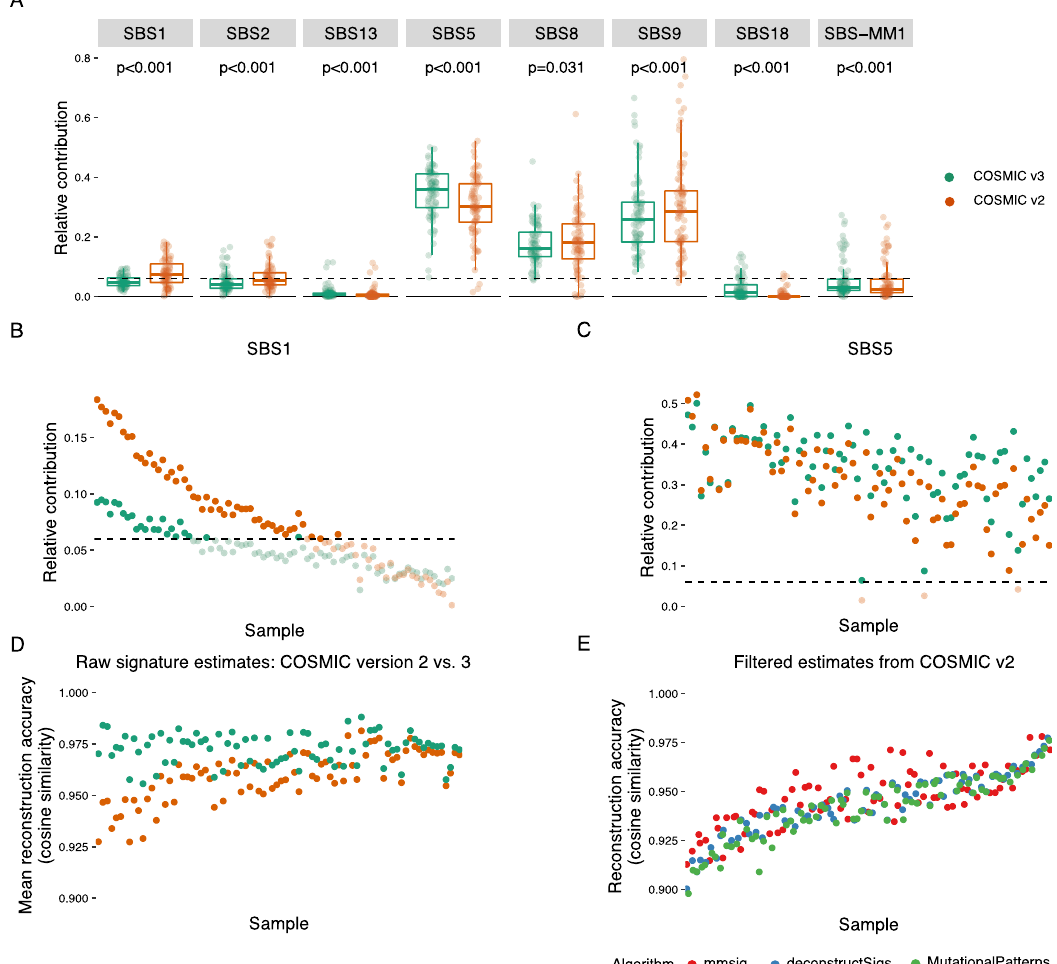
Fig. 3 The choice of mutational signature reference version signi fi cantly impacts the performance of fi tting algorithms. Un fi ltered mutational signature contributions for each sample were determined as the mean of estimates from deconstructSigs , mutationalPatterns , and mmsig (the three algorithms produced almost identical results). A The mutational signature contributions were signi fi cantly different depending on whether the original COSMIC v2 reference or the latest updated COSMIC v3.1 from Alexandrov et al. was used for fi tting 1,2 . Boxplots show the relative contribution of each signature in each sample, displaying the median and interquartile range with outlier samples drawn as dots. P -values were estimated by paired Wilcoxon tests. Dashed black lines mark the 6% relative contribution threshold used for fi ltering of results from deconstructSigs and mutationalPatterns . B , C Showing individual sample data from A for SBS1 and SBS5. B Estimates for SBS1 were generally higher using the old reference, where SBS1 contains “ contamination ” of a fl at background that may be better explained by SBS5. Notably, this resulted in SBS1 ending up above the 6% fi ltering threshold (dashed black line) in a higher fraction of samples using the old reference. C Estimates of SBS5 were generally higher using the new reference. D The overall cleaner mutational signatures in the new reference resulted in higher reconstruction accuracy compared with when the old reference was used. E When using the COSMIC v.2 reference, the reconstruction accuracy was similar irrespective of which fi tting algorithm was used: deconstructSigs , mutationalPatterns or mmsig . This is in contrast to the new reference, where mmsig was